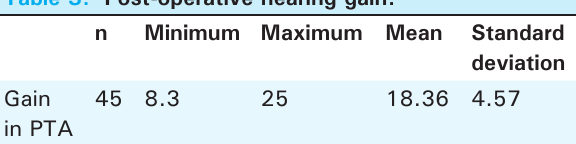
Table 3. Post-operative hearing gain.